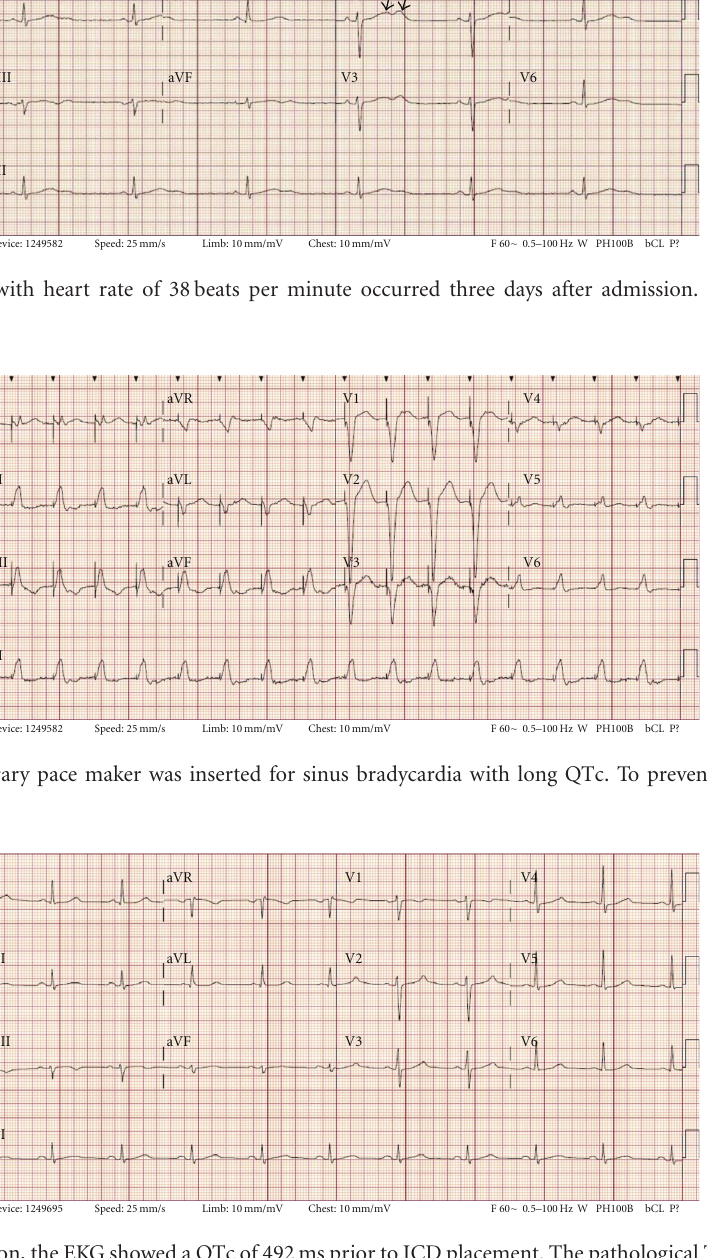
Figure 6: 23 days after admission, the EKG showed a QTc of 492 ms prior to ICD placement. The pathological T-U waves are no longer